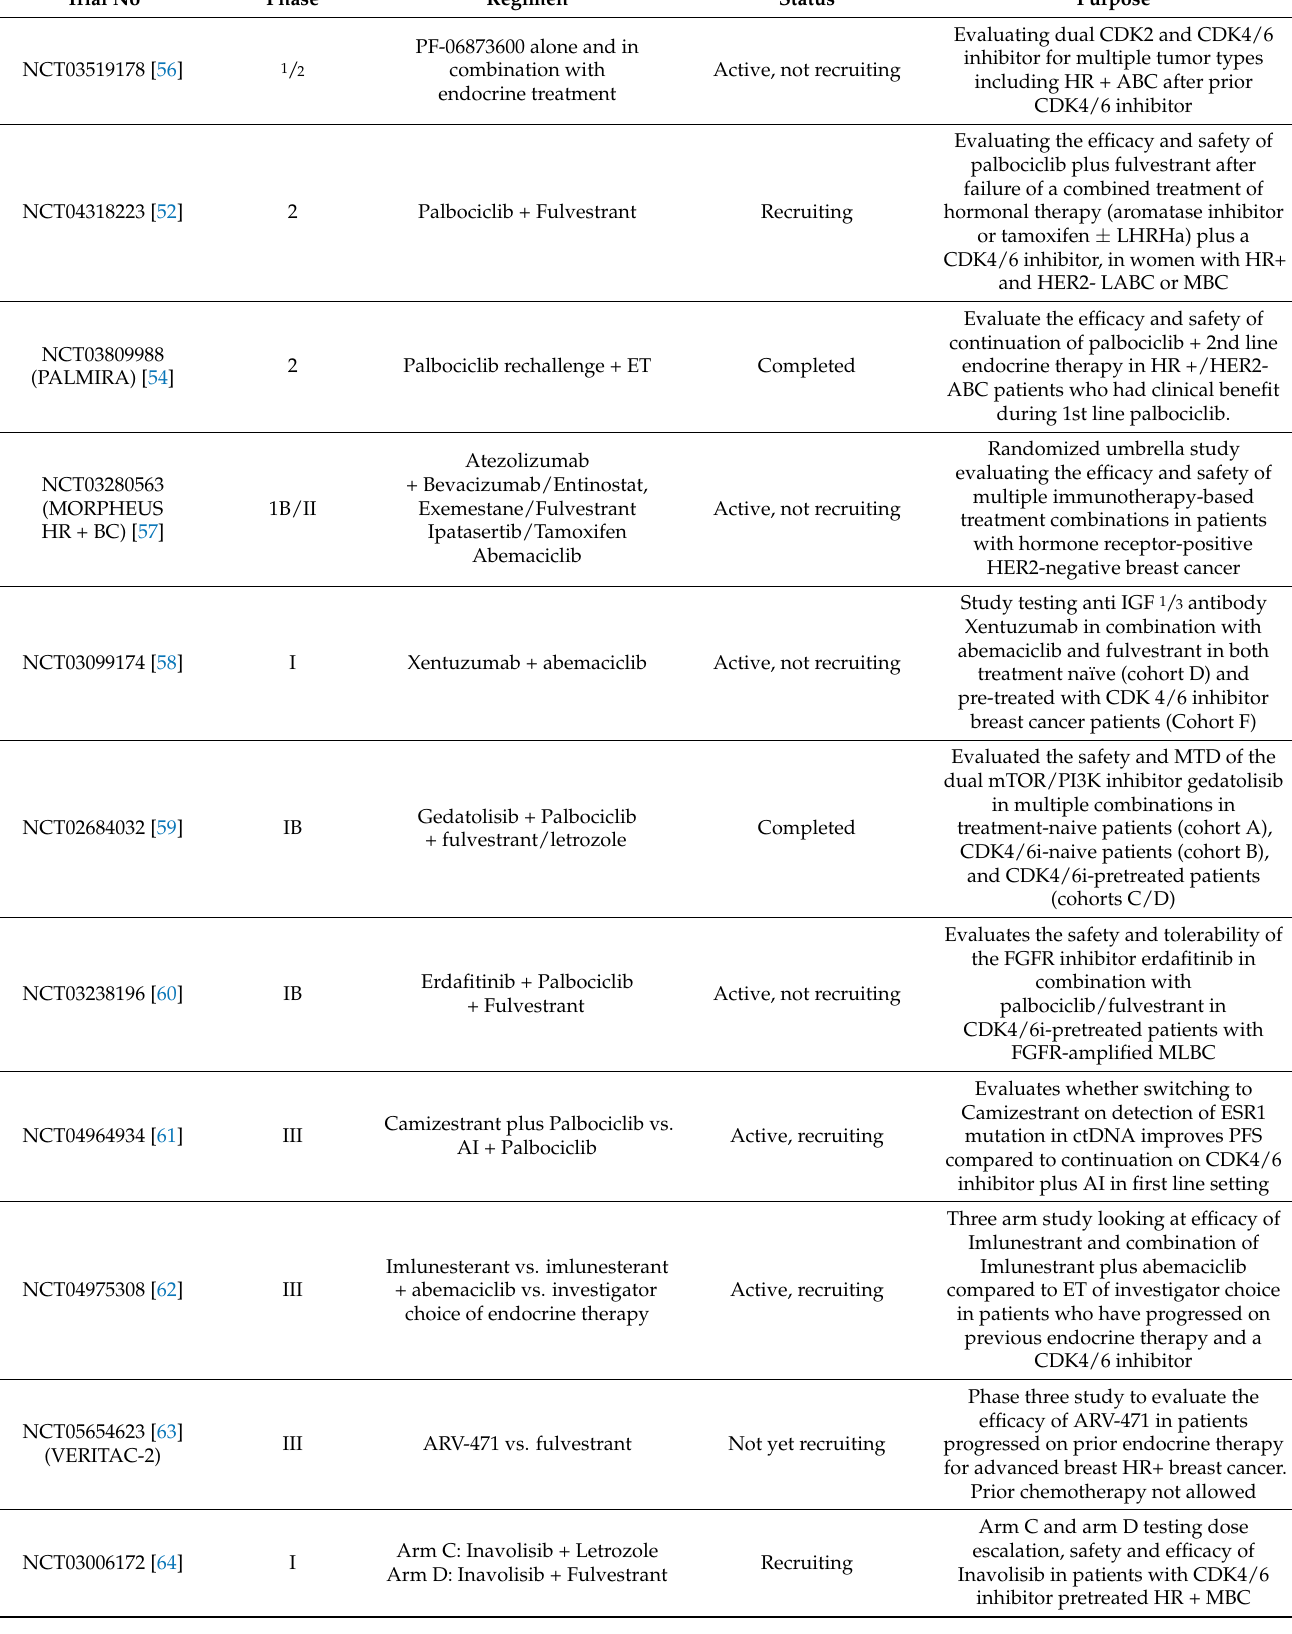
Table 1. Ongoing/completed 2nd line and beyond clinical